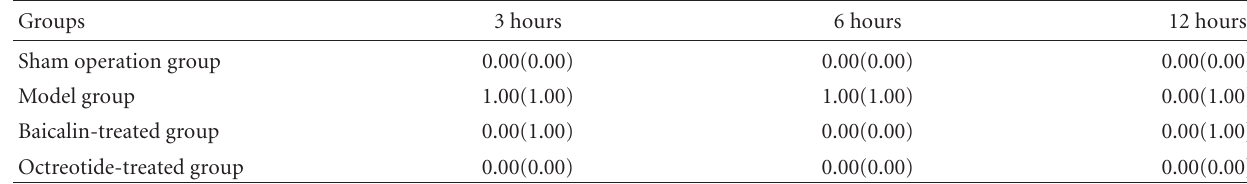
Table 4: Comparison of P-Selectin protein expression in all groups ( M ( Q R )).